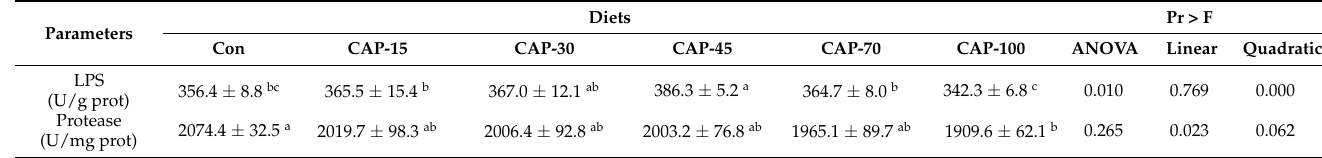
Table 7. Effects of dietary Clostridium autoethanogenum protein on digestive enzymes activity of largemouth bass.